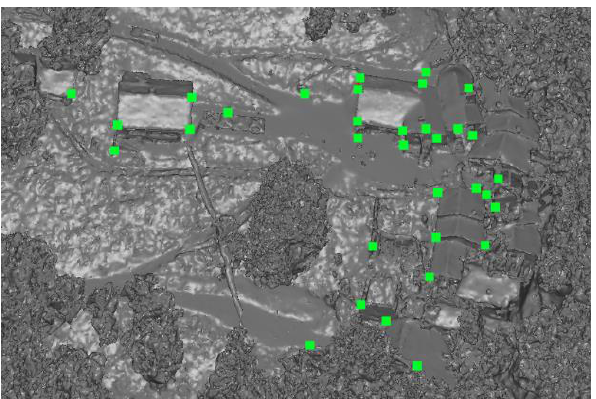
Figure 16. Discrepancy between the employed CPs and the point cloud